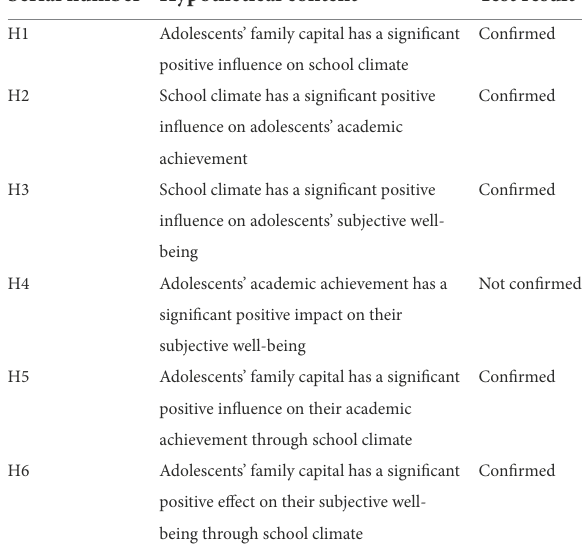
TABLE 9 Summary of test results for research hypotheses. Serial number Hypothetical